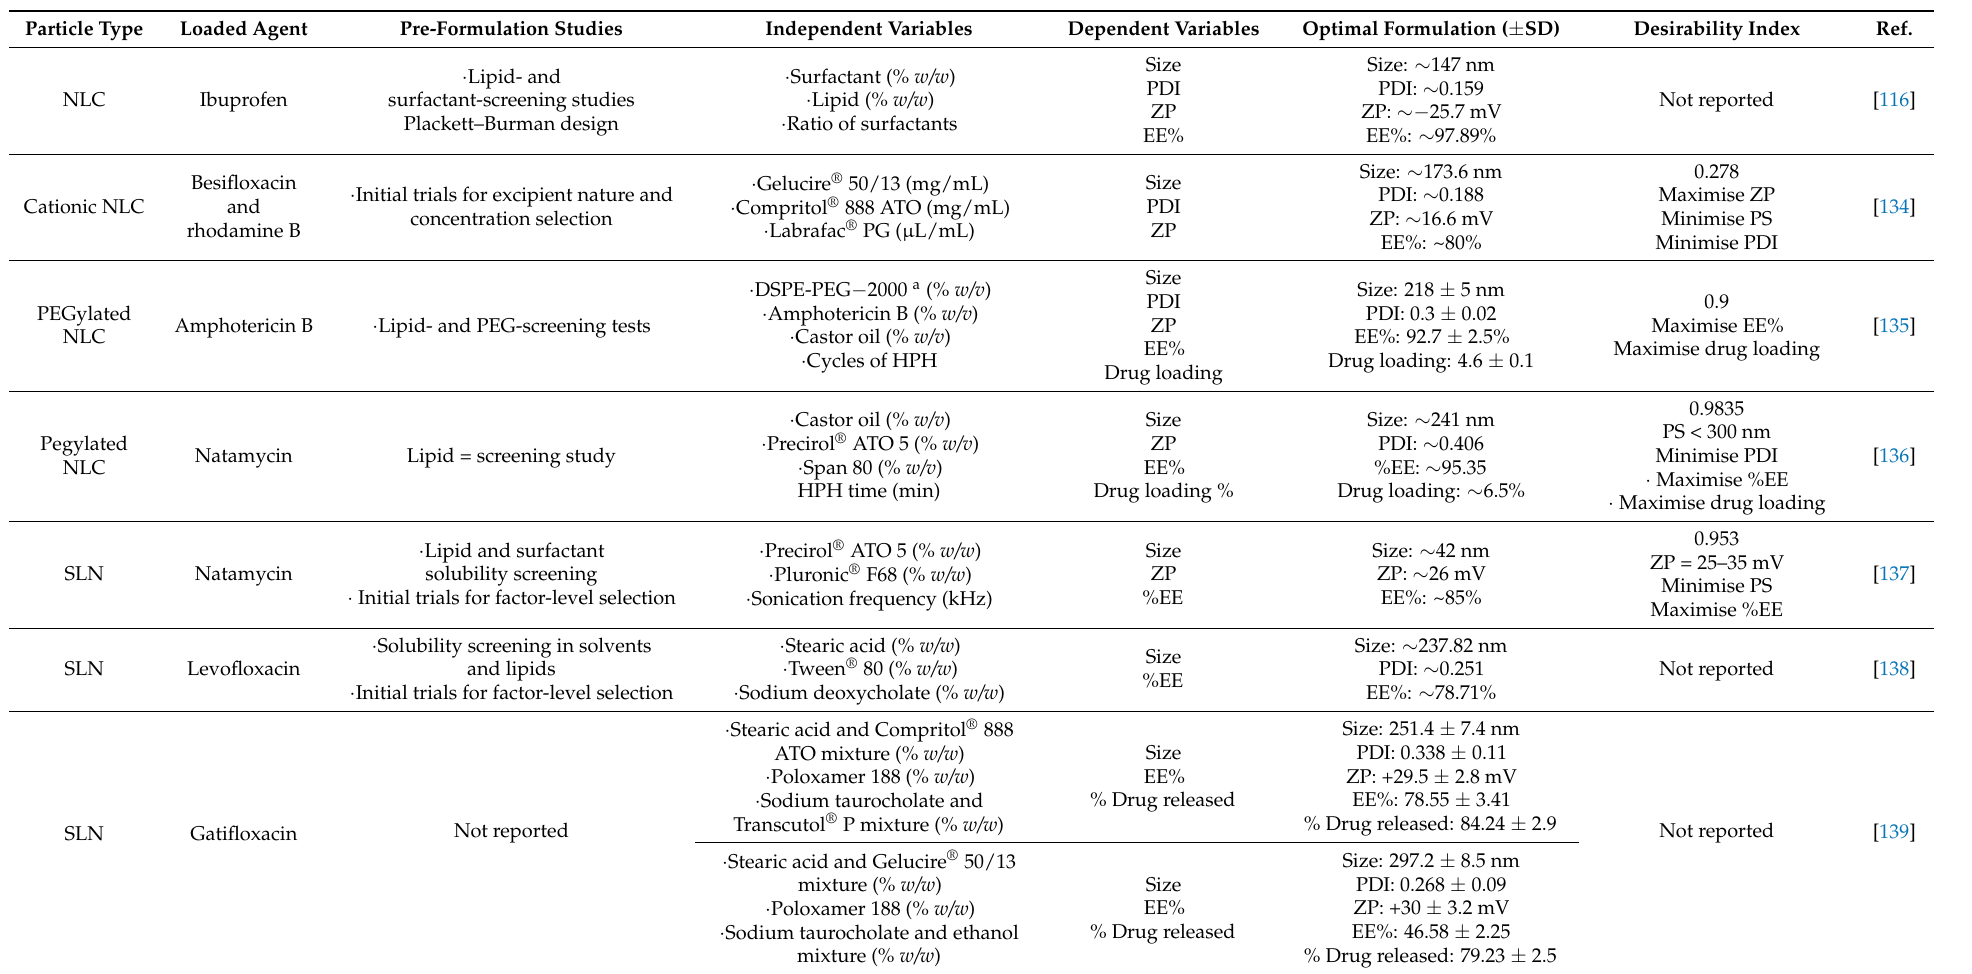
Table 4. Examples of the application of Box–Behnken designs in the production and optimisation of lipid-based nanocarriers intended for ocular delivery. Particle